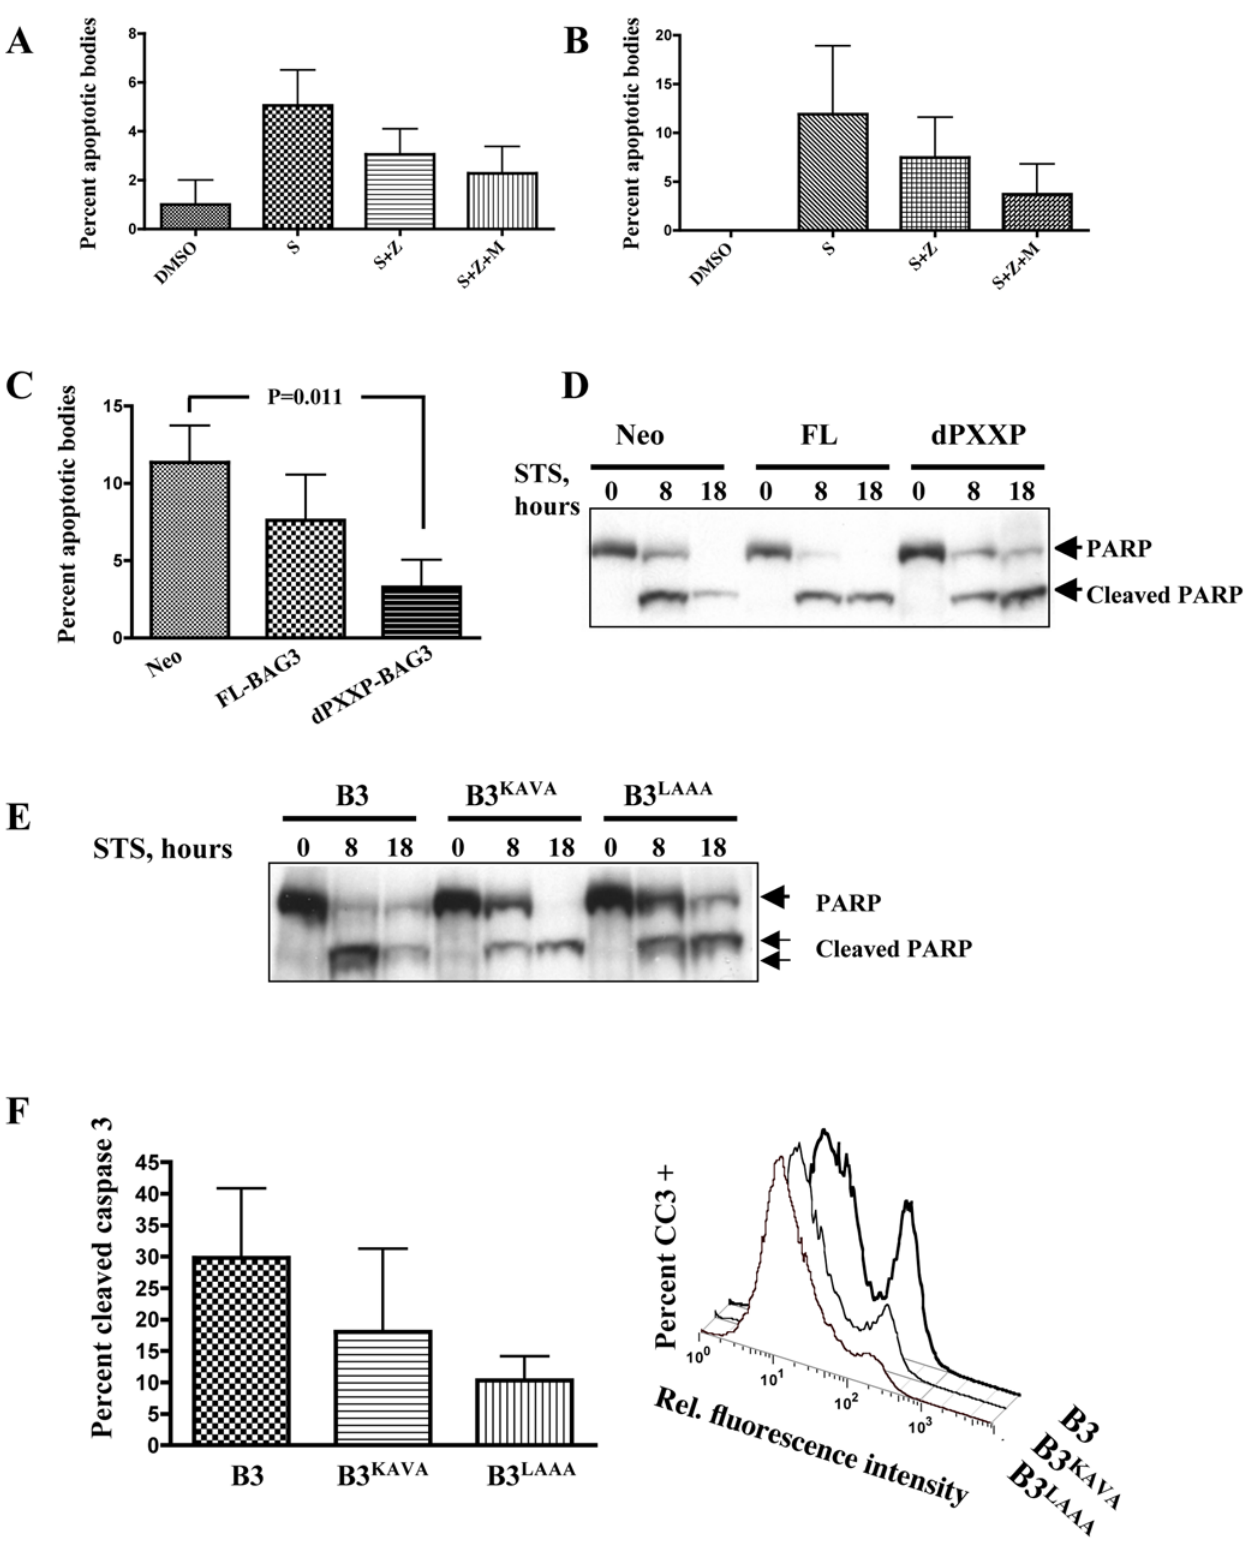
Figure 6. Absence of caspase cleavage of BAG3 confers cellular protection against STS-mediated apoptosis. A, B. STS-induced apoptosis was reduced with caspase and proteasome inhibition. Cells were pretreated with MG-132 for 4 hrs and treated with 2 m M STS and 85 m M zVAD-fmk for an additional 8 hrs. Wild type MDA435 (A) and FL-BAG3 overexpressors were fixed and stained with DAPI and apoptotic bodies scored from 3–5 independent fields; data represent mean and SEM (n=2). C. Apoptosis is delayed in dPXXP-BAG3 lacking 344 KEVD. At 8 hours of STS exposure, reduction in apoptotic bodies is seen in FL-BAG3 overexpressing cells and in dPXXP-BAG3 cells; 11–14 random fields were scored, data represent mean and SEM. D. PARP cleavage and loss of total PARP is reduced in dPXXP-BAG3 cells. STS exposure resulted in reduced PARP cleavage in